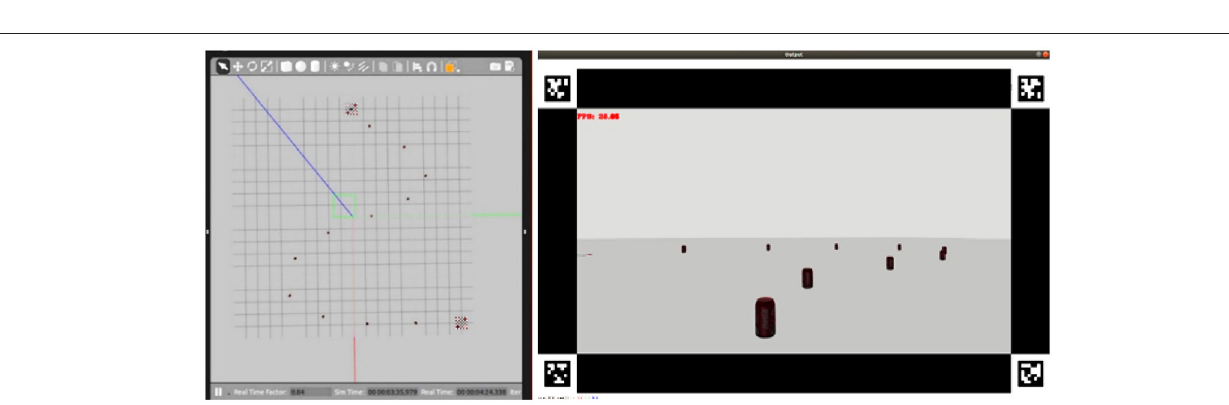
experiment: one for the perceived embodiment of the device and one concerning the quality of the virtual